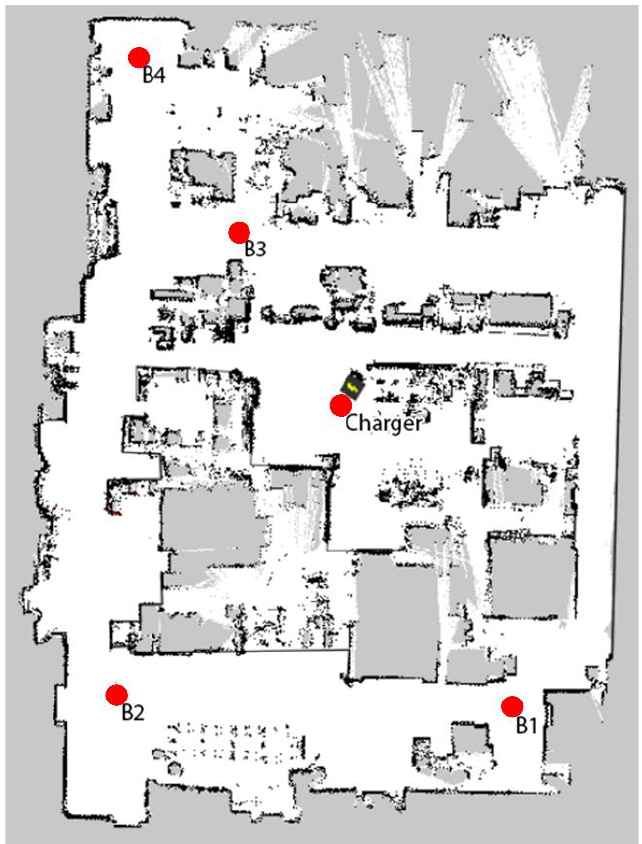
Figure 1. Part of the production hall layout with marked workstations to be operated by the MiR100 robot and the area where the robot can create transportation routes. A mission has been planned through the points B1–B4 and has been executed with and without the obstruction of path between points B2 and B3. A simplified version of the experimental mission is presented in Figure